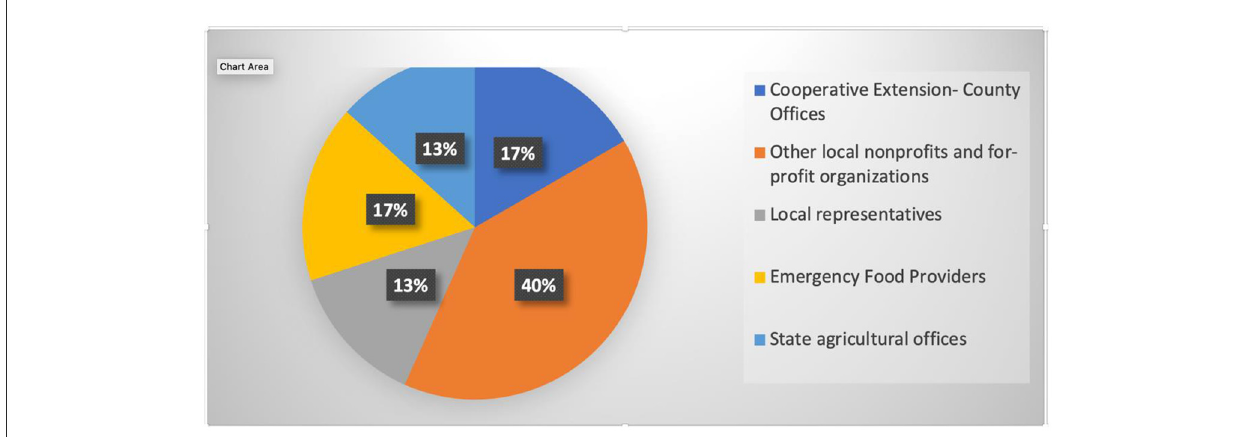
FIGURE4 Collaborations reported by interviewed and observed for web-researched organizations in the Hudson Valley (excluding partnerships/collaborations related to land ownership). Source: Interviews and website analysis.